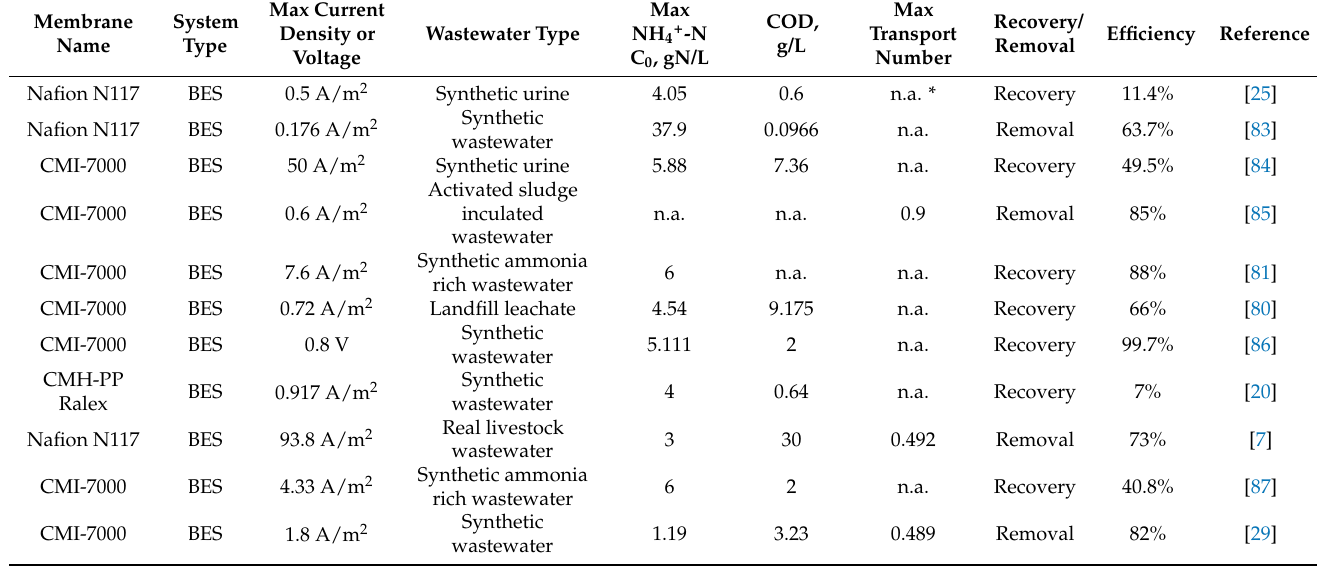
Table 2. Summary of performances of electrochemical